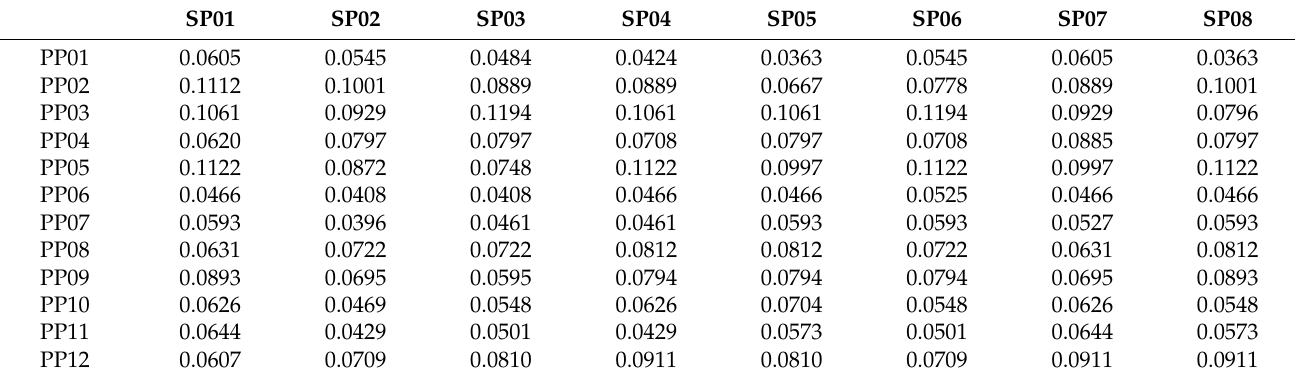
Table 4. Weighted normalized matrix.